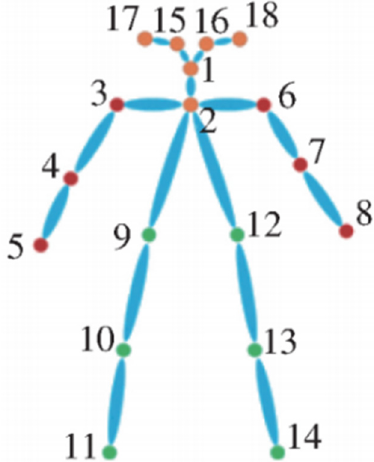
Figure 2. Pedestrian key points. Table 1. Index of pedestrian key points.